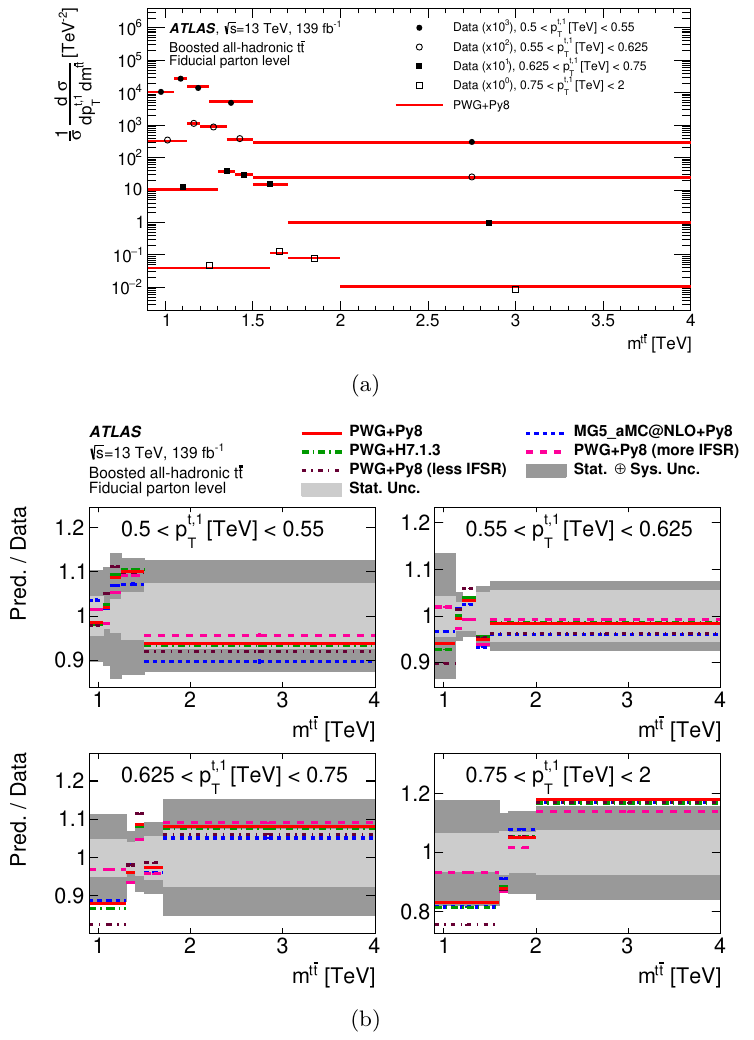
Figure 28 . (a) Normalized parton-level fiducial phase-space double-differential cross-sections as a function of the p T of the leading top quark and the invariant mass of the t ¯ t system, m t ¯ t , compared with the Powheg+Pythia 8 calculation. Data points are placed at the centre of each bin and the Powheg+Pythia 8 calculation is indicated by solid lines. The measurement and the prediction are normalized by the factors shown in parentheses to aid visibility. (b) The ratios of various MC calculations to the normalized parton-level fiducial phase-space differential cross-sections. The dark and light grey bands indicate the total uncertainty and the statistical uncertainty, respectively, of the data in each